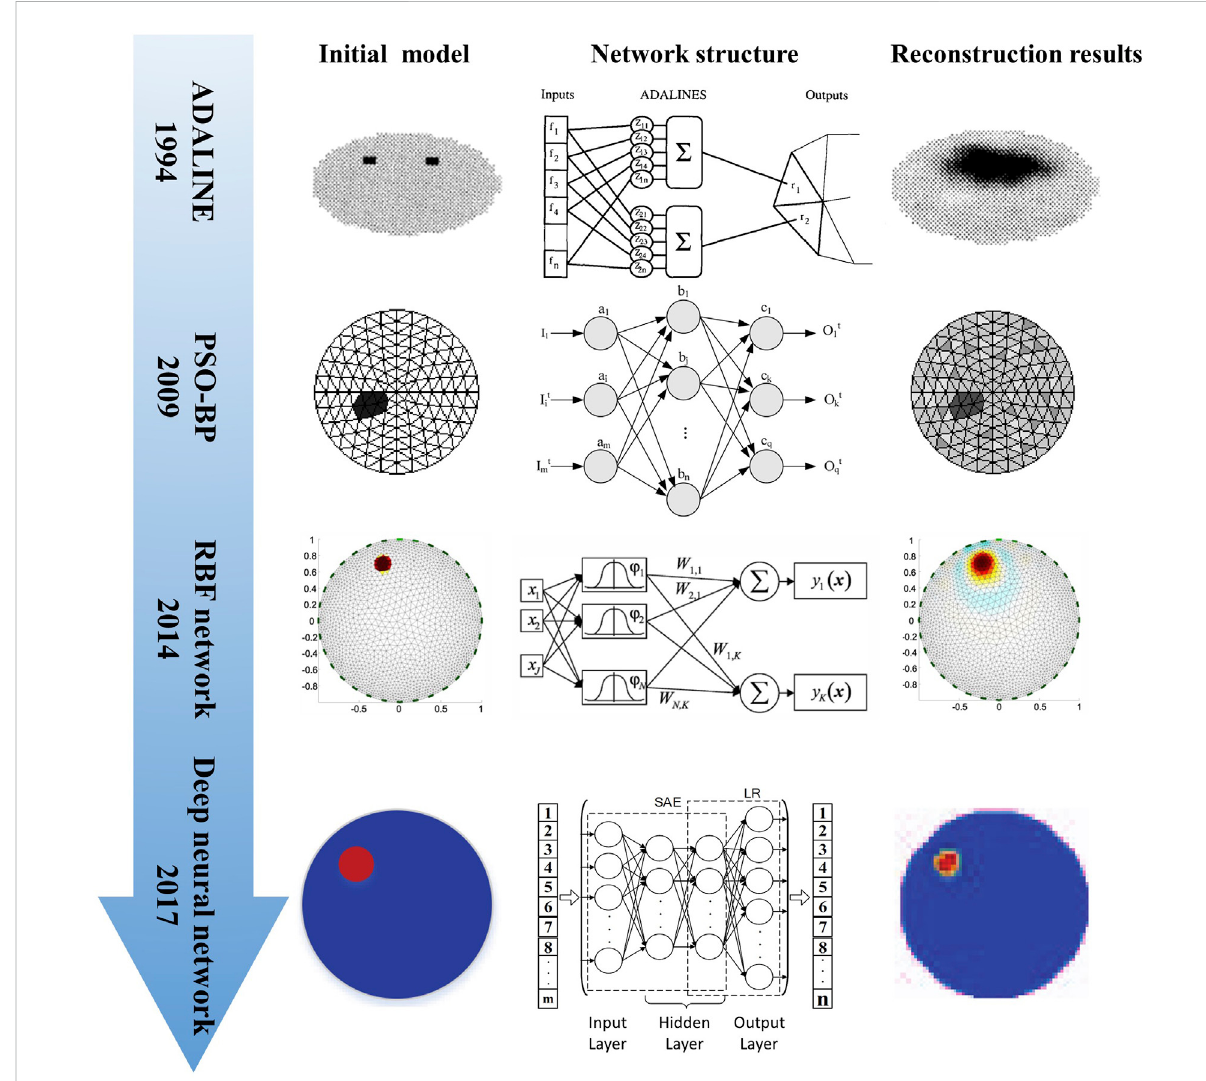
FIGURE 2 Progressin EIT reconstruction based on conventional neural networks (Adler and Guardo, 1994; Wang et al., 2009a; b; Michalikova et al., 2014; Li et al., 2017).